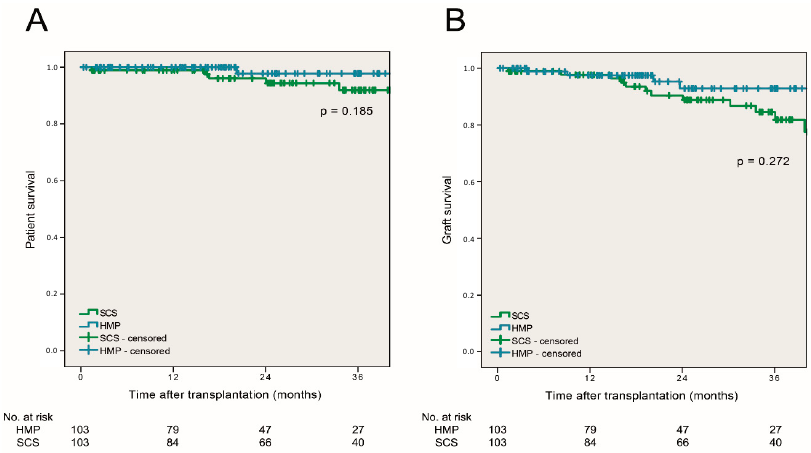
Figure 3. ( A ) Estimated 3-year patient and ( B ) 3-year graft survival rates after transplantation of HMP and SCS kidneys.